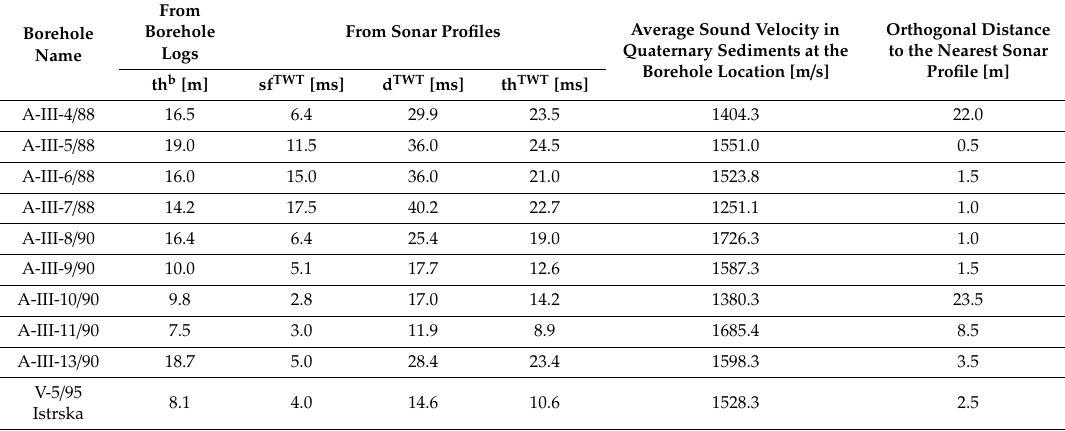
Figure 4. Sub-bottom sonar profiles (with superimposed boreholes) where the top of the Eocene succession is expressed as a medium-to-high amplitude reflection unit with a well-definable top from which downward shallow-dipping reflections emerge (( a – c )). For profile locations, see Figure 2. For an explanation of the color overlays, the reader is referred to Figure 3. Table 2. Thickness of Quaternary sediments at borehole locations from borehole logs (th b ) and sonar profiles (th TWT ), the depth of the seafloor (sf TWT ), and the top of the bedrock (d TWT ) from the sonar profiles and the calculated average sound velocity in Quaternary sediments at the borehole